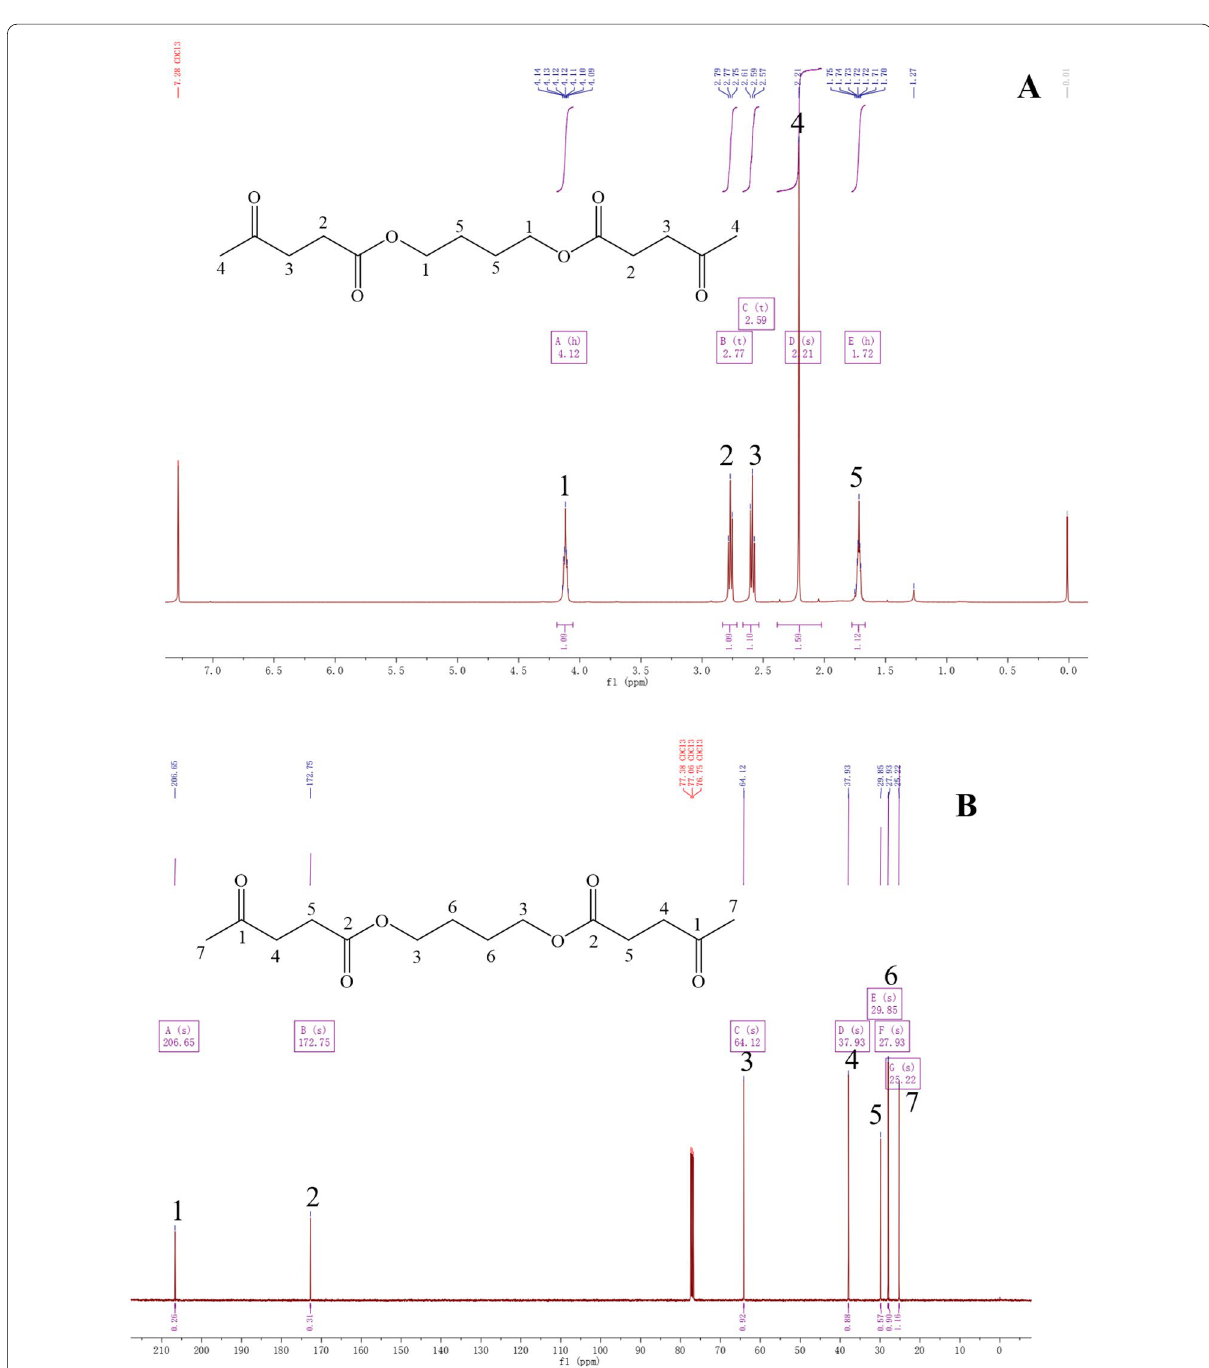
Fig. 5. 1 H NMR and 13 C NMR spectra of LBE ( A 1; 2; 3; 4; 5 for different hydrogen labeling and chemical structure corresponding to the position. B 1;2;3;4;5;6;7 for different carbon labeling and chemical structure corresponding to the